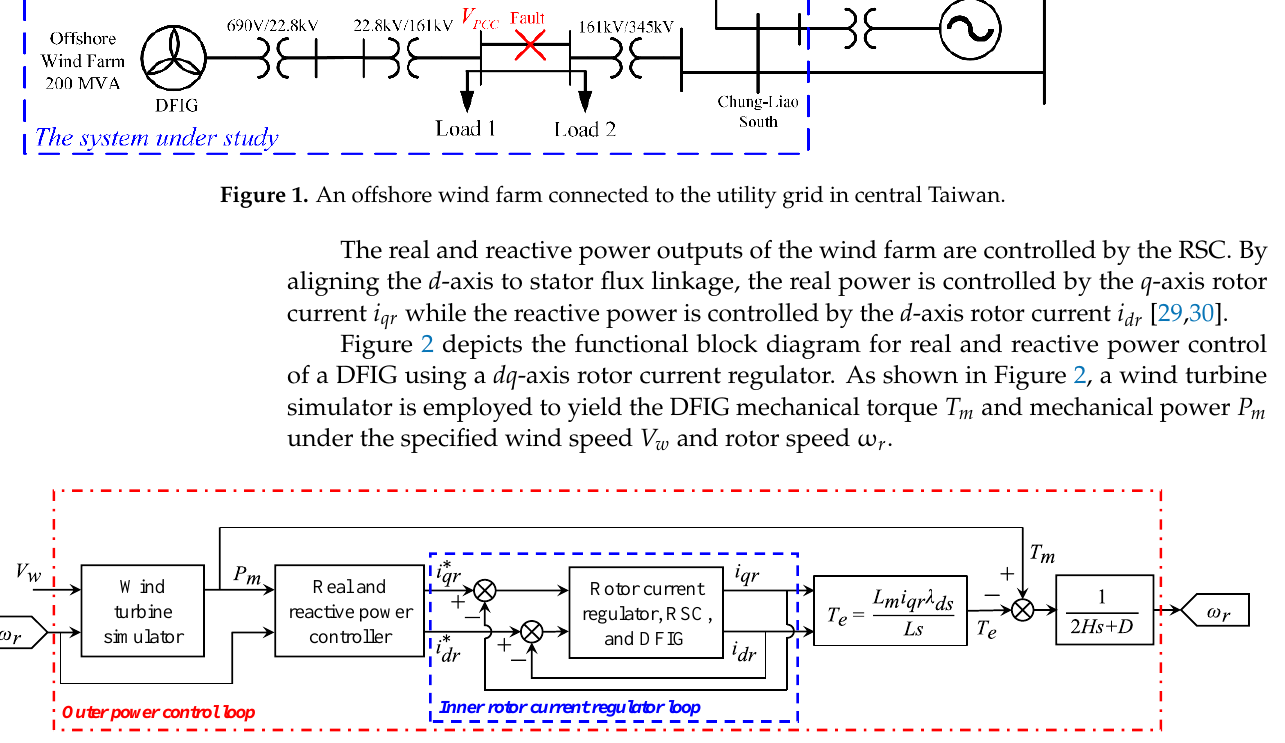
Figure 2. Functional block diagram for real and reactive power control of a doubly fed induction generator (DFIG).